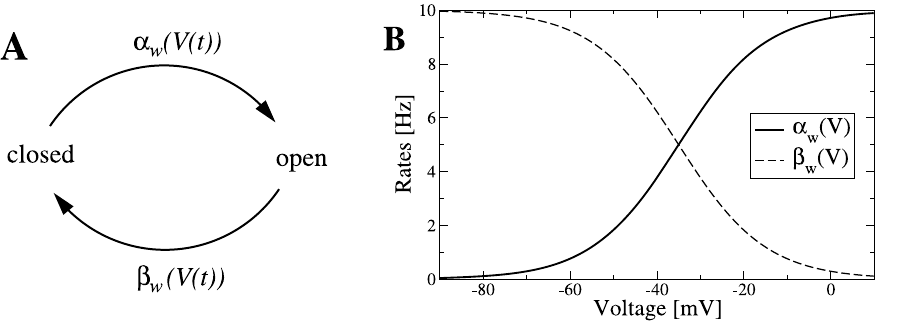
Figure 13. Channel model with voltage-dependent transition rates. A In a simple model of a M-type adaptation channel, the slow voltage- gated adaptation current is mediated by a population of slow ion channels that can be either in an open or a closed state. In the activation state ( w ? ~ 1 ), channels open with rate a w , in the deactivation state ( w ? ~ 0 ) channels close with rate b w . B Both transition rates show a sigmoidal dependence on the voltage (Eq. (24) and (27), t w ~ 100ms